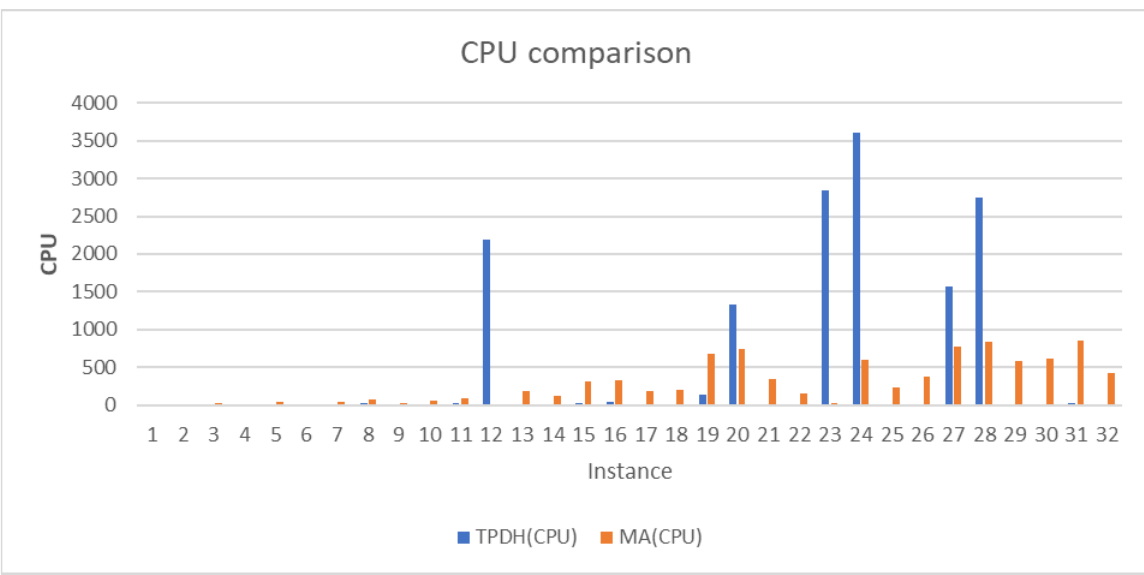
Figure 3. Computation time comparison.